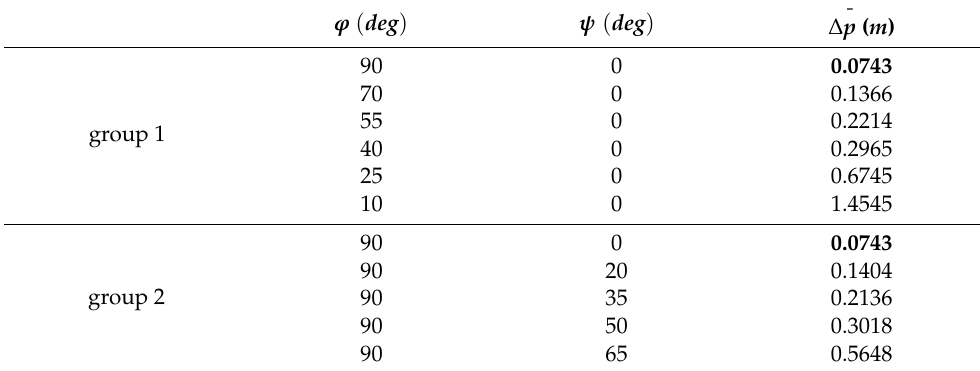
Table 9. The 3D RMSPE ∆ p with varying angles ϕ and ψ for the LOS condition.